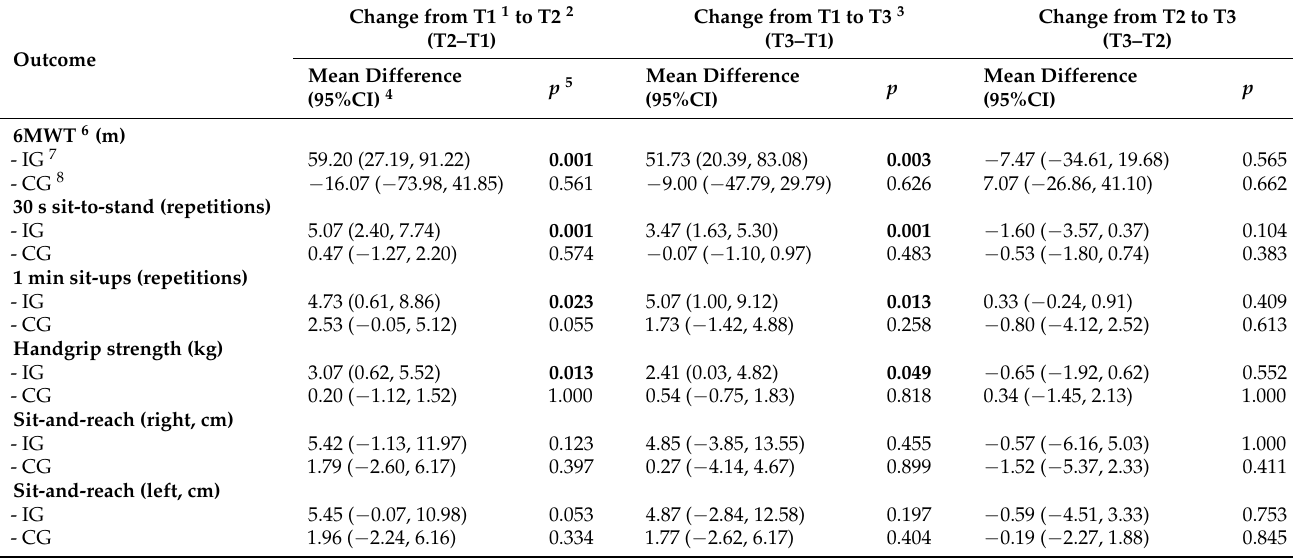
Table 5. Within-group differences in HRPF-related outcomes.